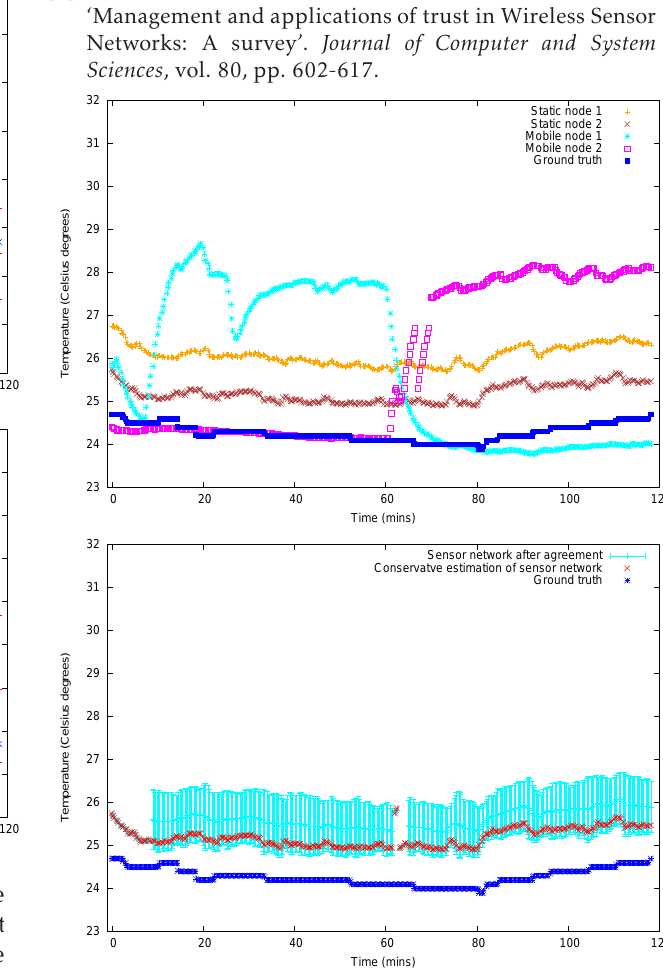
Figure 4. Individual recordings of the nodes of the sensor network for the parameter “temperature” (top) and revised estimations of “temperature” relying on two variations of our network agreement- based approach